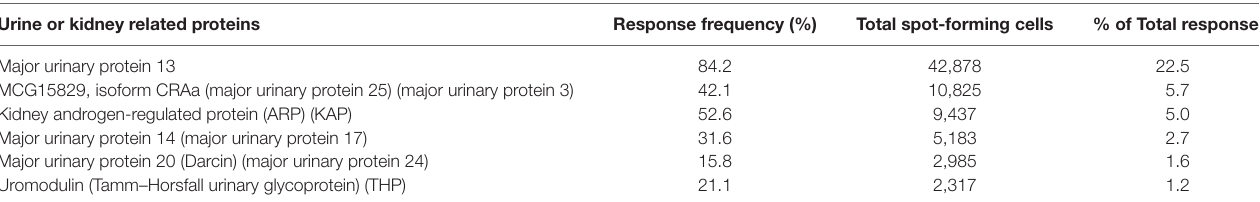
response, 5 peptides contained hydroxyproline residues, and 1 particular hydroxyproline peptide elicited the highest magni- tude of response (7% of total response). In terms of protein source, Table S5 in Supplementary Material also lists whether the proteins from which the peptides are derived are urinary/kidney proteins or not. Strikingly, the majority (94/116) of the immunogenic peptides were derived from non-urine related sources representative of 36 different proteins. These peptides accounted for a higher magnitude of responses (61.4%) than urine and kidney related proteins ( Figure 3C ). Major urinary proteins, KAP, leucine-glycoprotein, uromodulin, collagen, Meprin A, and Egf have already been TaBle 1 | Protein sources of urine or kidney reactive peptides. Urine or kidney related proteins